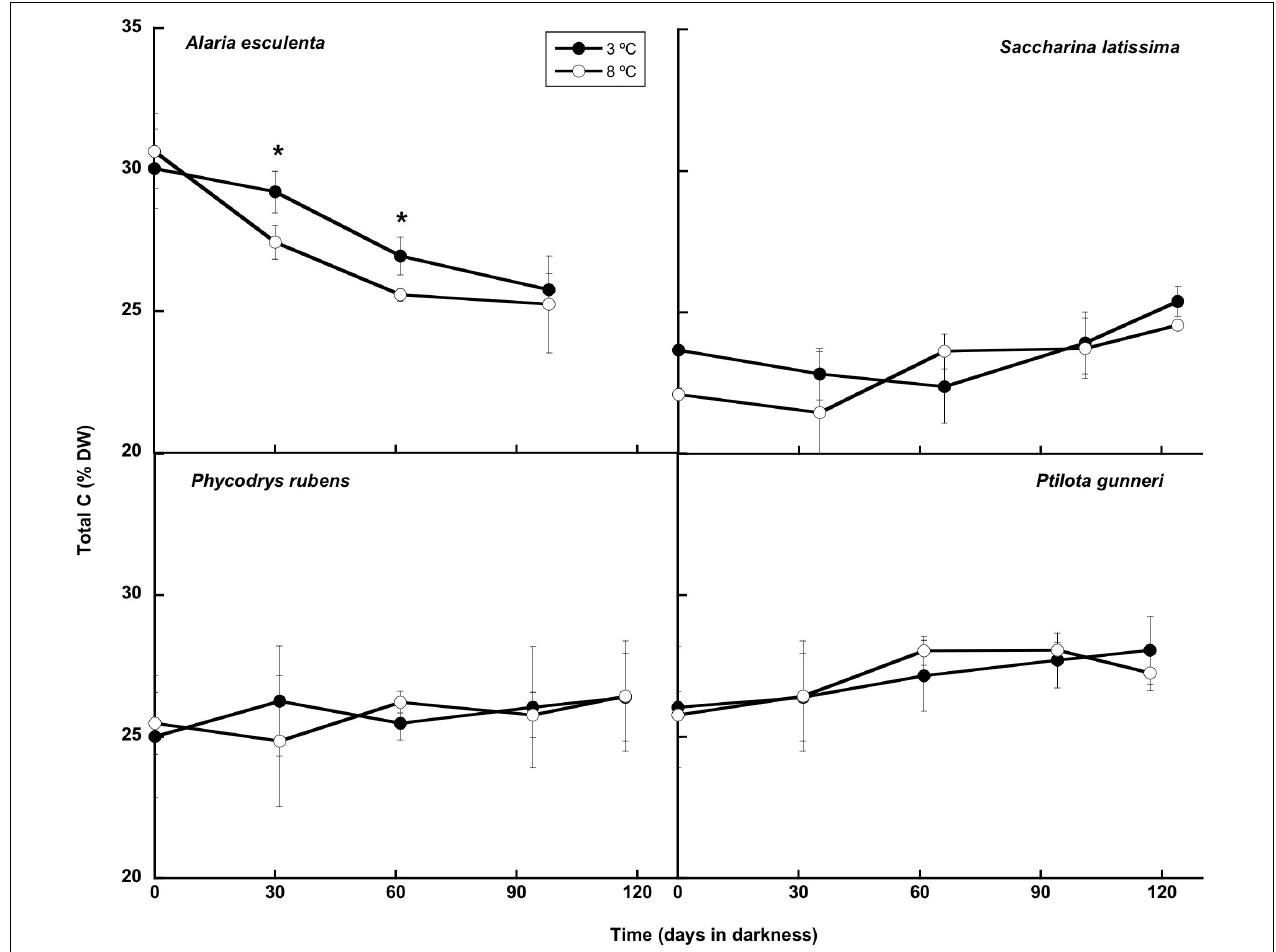
FIGURE 7 | Total C during the 16 weeks of incubation in darkness of Alaria esculenta , Saccharina latissima , Phycodrys rubens , and Ptilota gunneri at two different temperatures. Data are mean of 5 replicates (error bars for standard deviation). Significant differences between temperatures marked with an